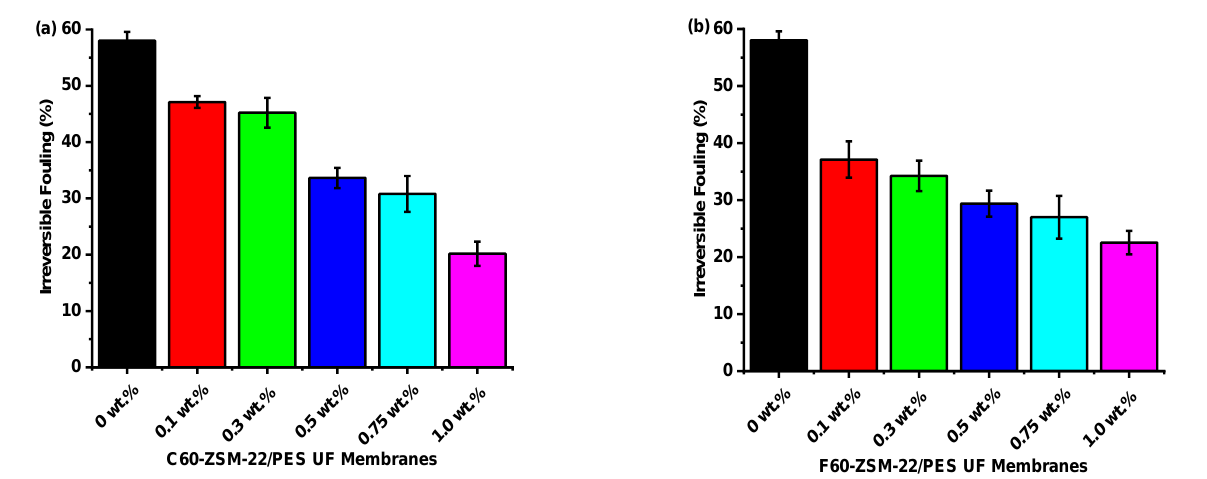
Figure 14. Irreversible fouling analysis of nanofiltration membranes prepared via phase inversion to nominal wt.% loadings of 0, 0.1, 0.3, 0.5, 0.75, and 1.0 using ZSM-22 zeolite as nanoadditives: ( a ) C60-ZSM-22/PES and ( b ) F60-ZSM-22/PES.